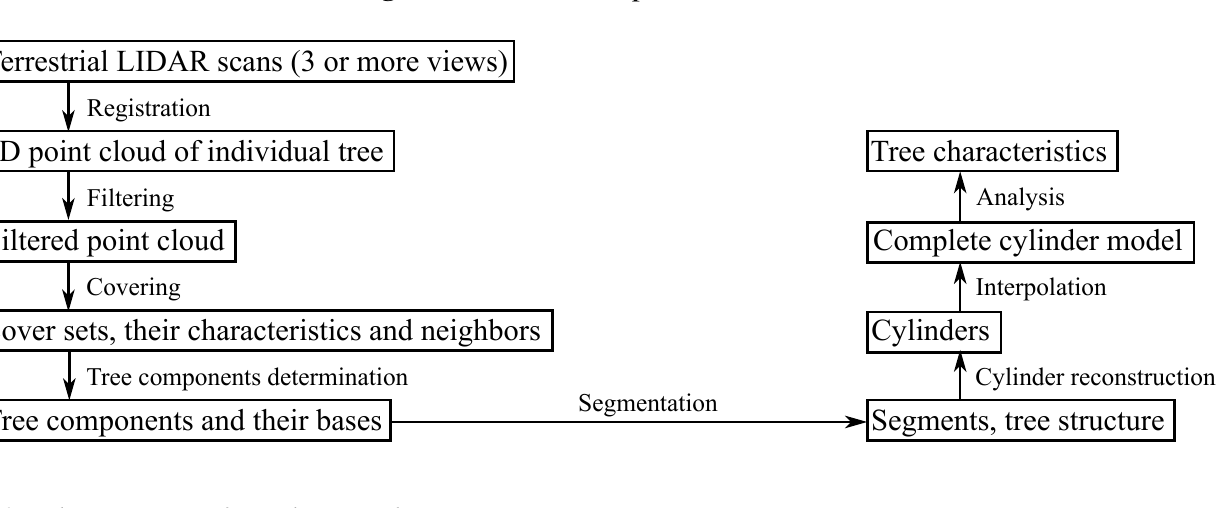
Figure 4. The main steps of the